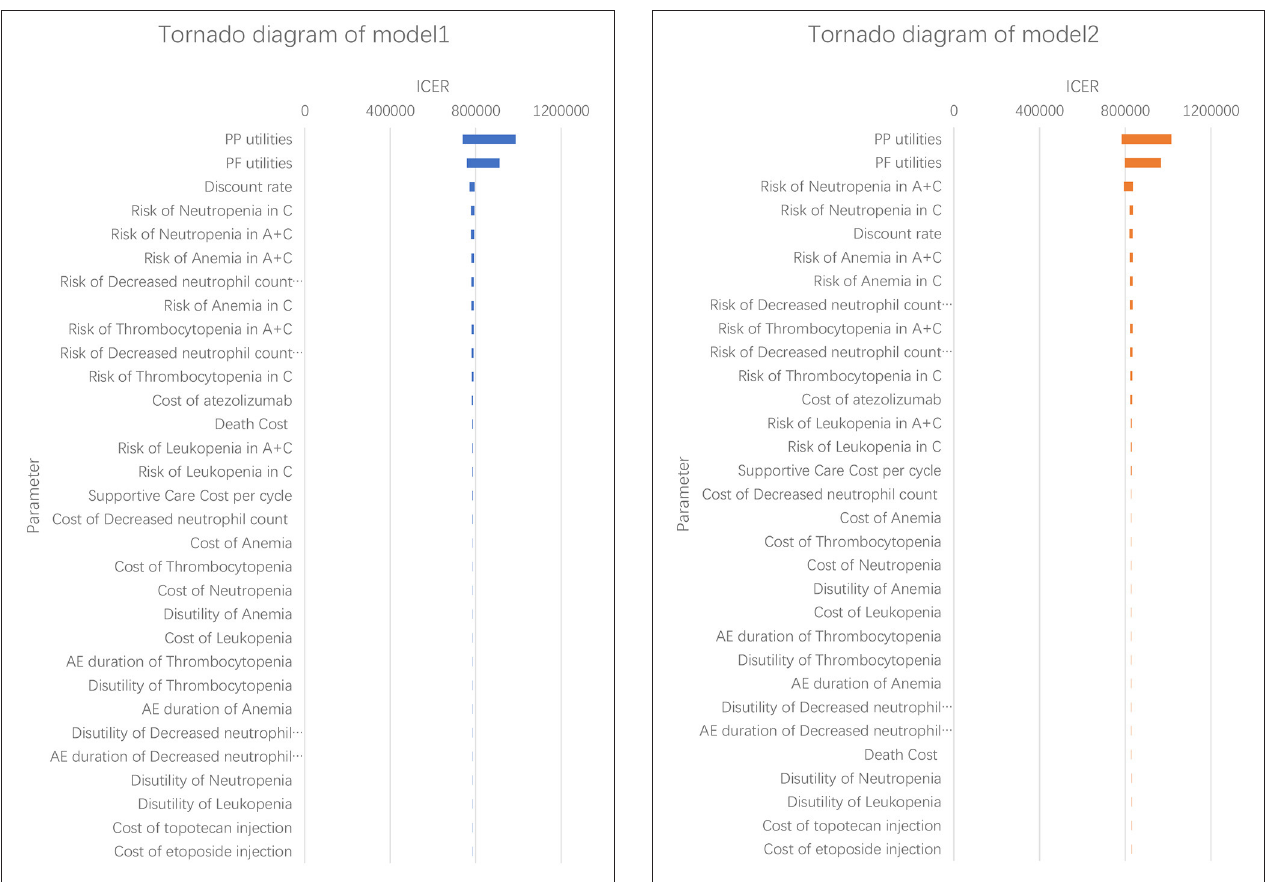
FIGURE 3 | Tornado diagram of the one-way sensitivity analysis in model 1. A + C, atezolizumab + chemotherapy; C, chemotherapy.